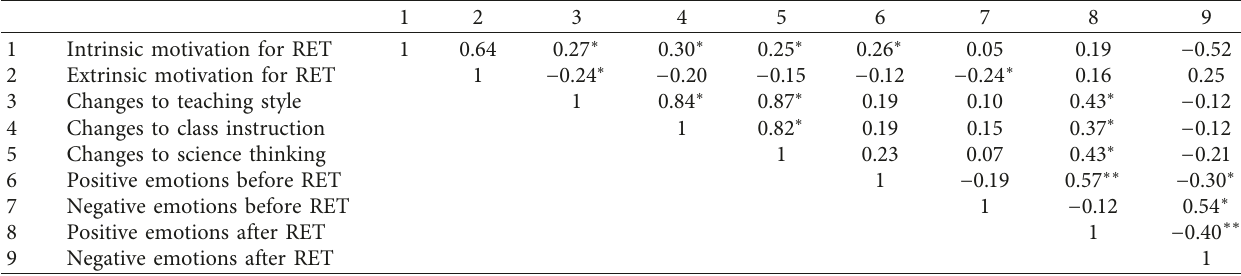
Table 3: Correlations among major study